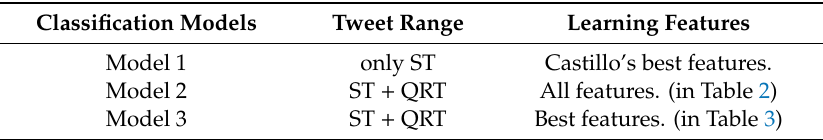
Table 6. Definition of classification modes by Learning features.